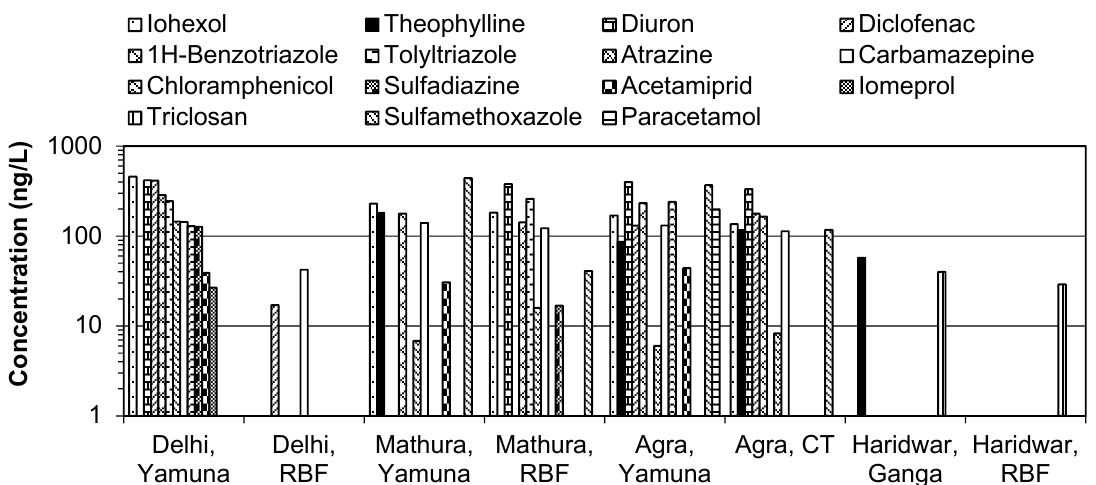
Figure 4. Median concentrations (except for Mathura) of organic micropollutants (OMPs) in surface water, RBF well water (RBF), and conventionally treated (CT) drinking water at selected sites sampled in non-monsoon 2014. Number of samples ( n ): Delhi: Yamuna, n = 2, n RBF = 5; Mathura: Yamuna, n = 1, n RBF = 1; Agra: Yamuna, n = 3, n CT = 2.